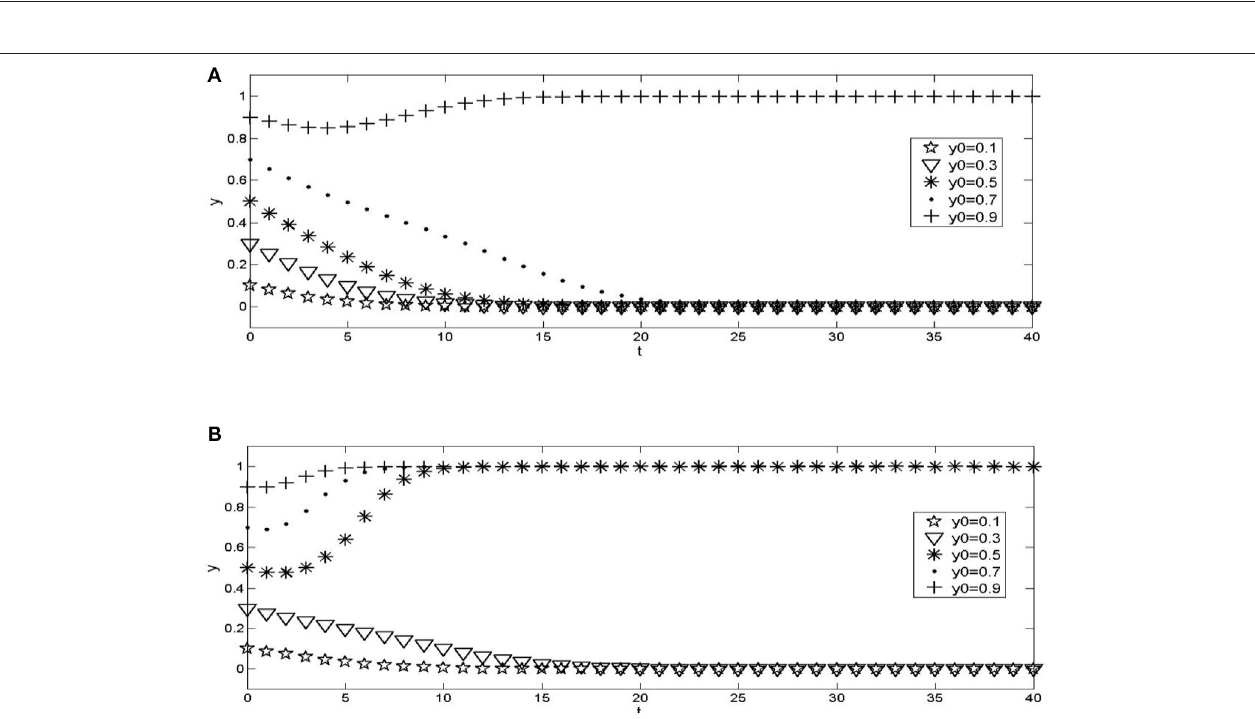
FIGURE 4 | The impact of changes in government incentives given by urban hospitals and community health service institutions on the evolution results. (A) G 3 = 0, G 4 = 0; (B) G 3 = 0.5, G 4 =